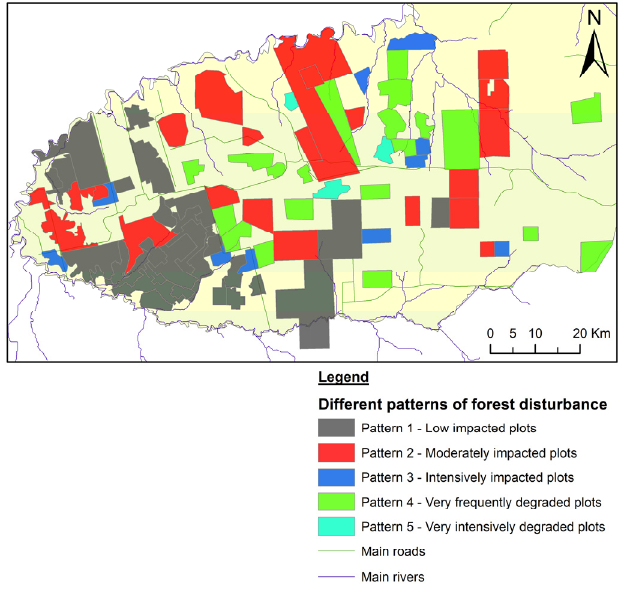
Figure 6. Map of the five different patterns of forest disturbance occurring in the 81 studied plots to the southwestern of the municipality of Paragominas.